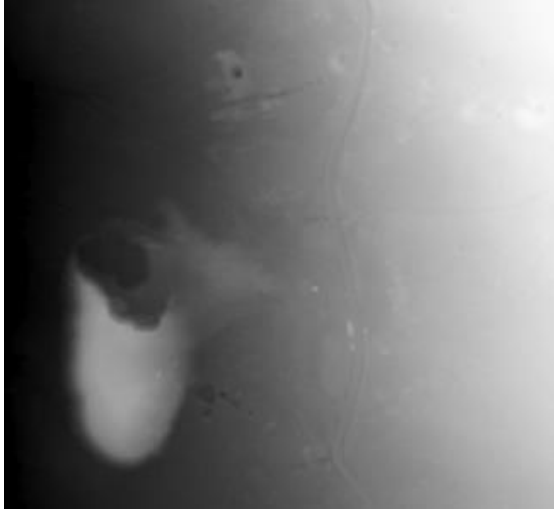
Figure 3. Generated DRM from low-cost ALS (Eastern